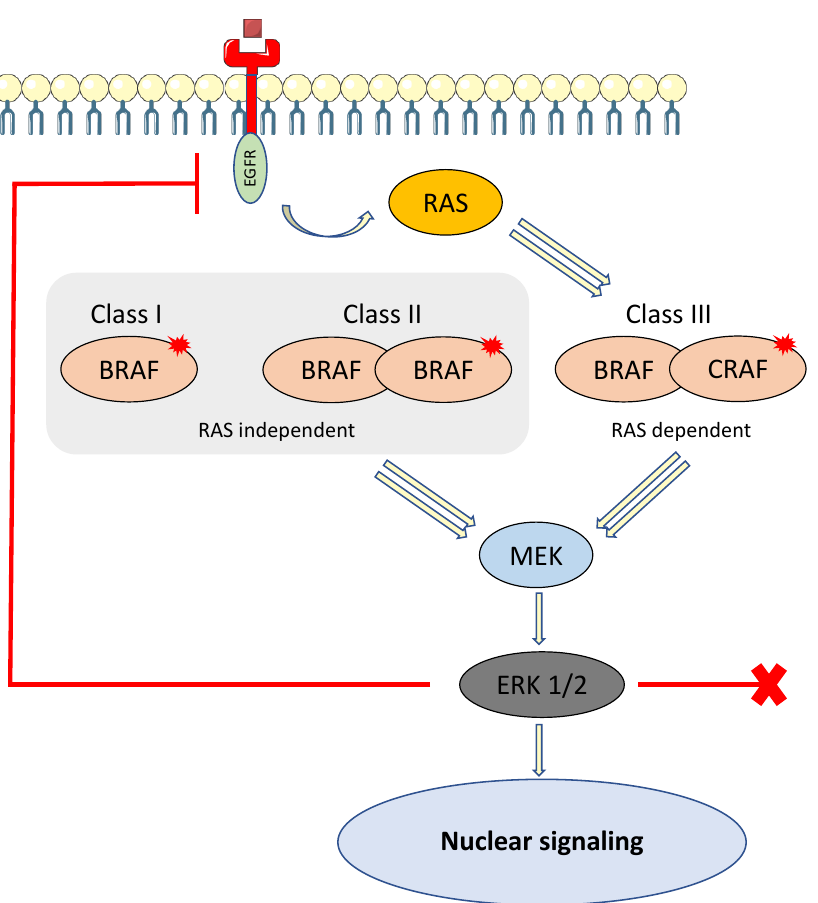
Figure 2. BRAF family and activation of the MAPK pathway.